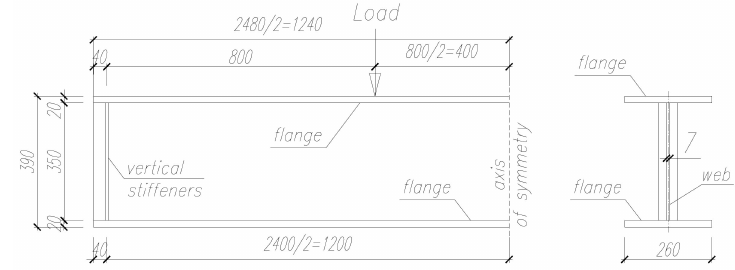
Figure 1. Loading configuration of the analyzed beams—distribution of internal forces.